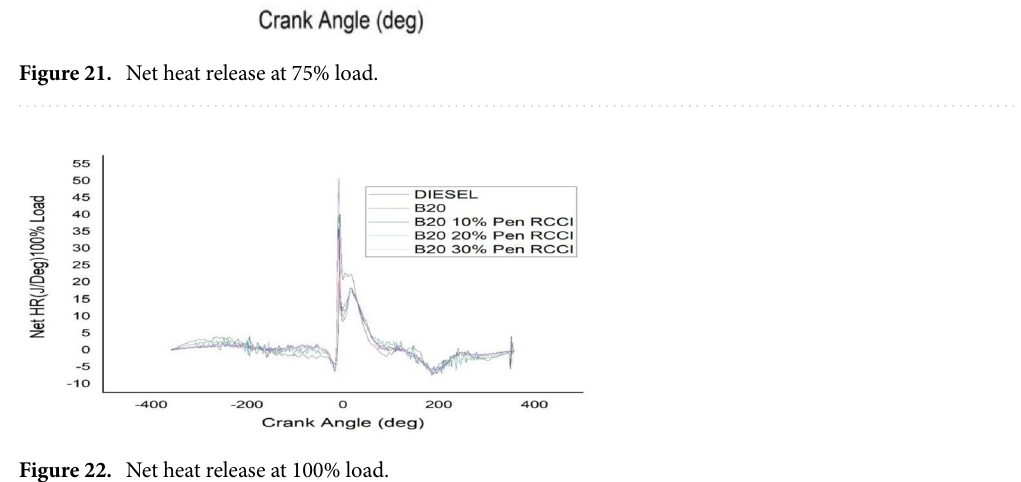
Figure 22. Net heat release at 100%